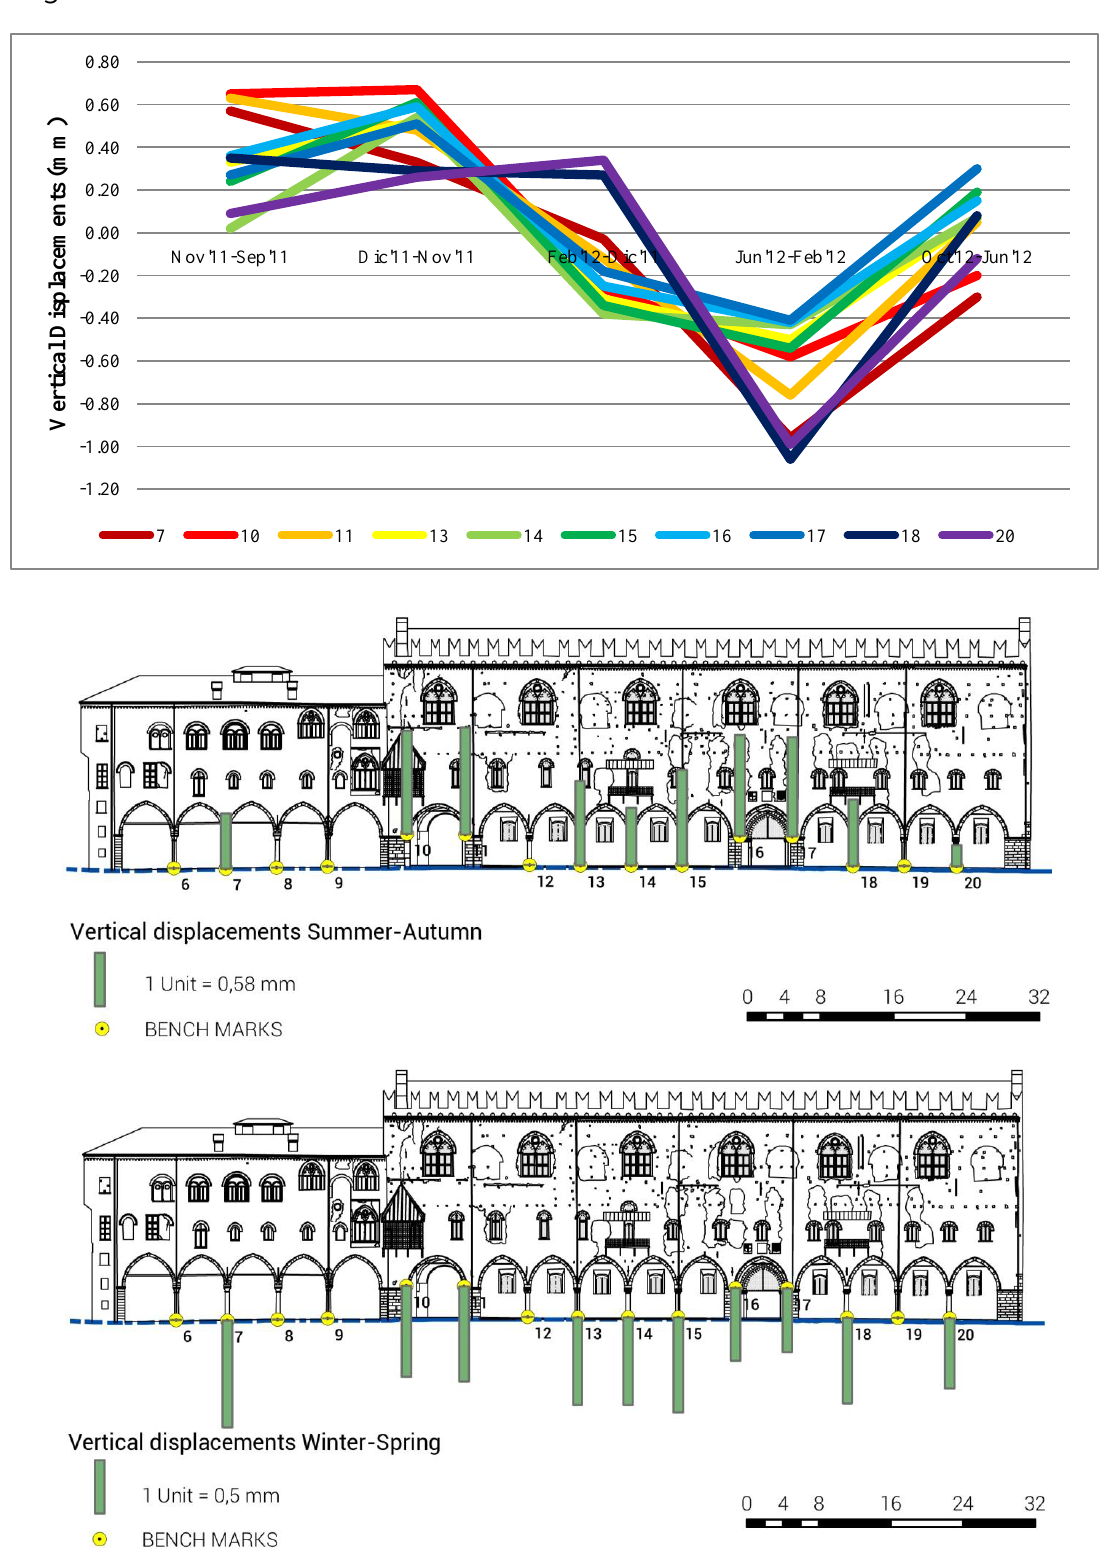
Figure 10. Evolution of the vertical displacements of the Palazzo del Capitano and Magna Domus